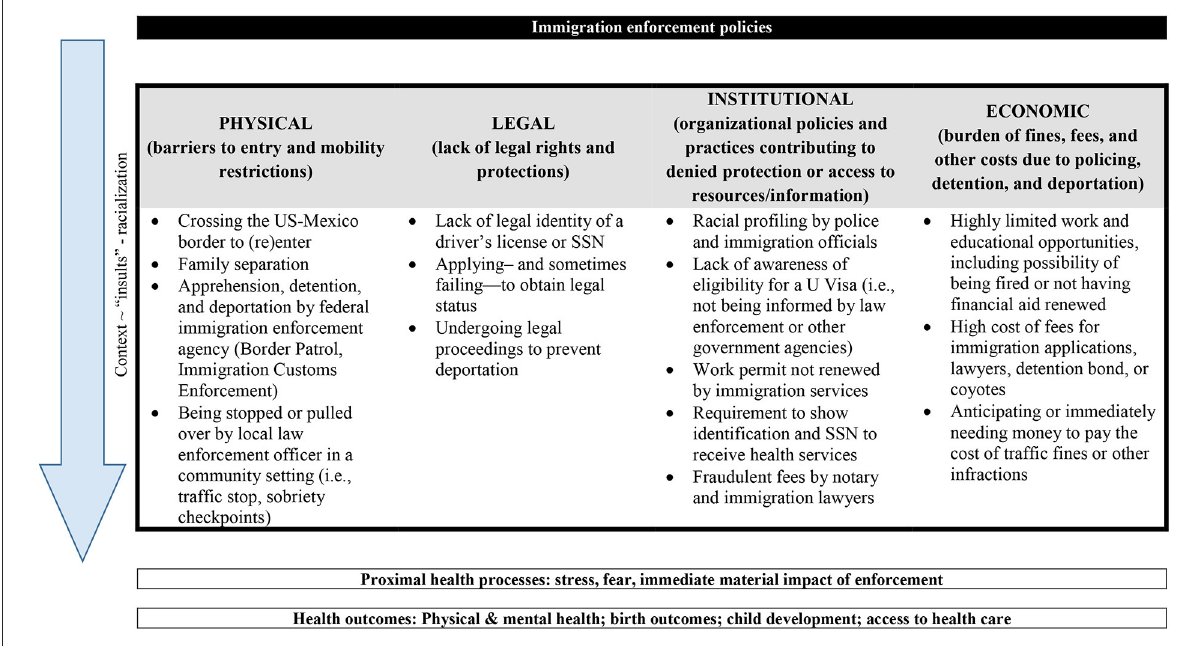
FIGURE1 A framework of the structural impacts of enforcement policy on Latino immigrant